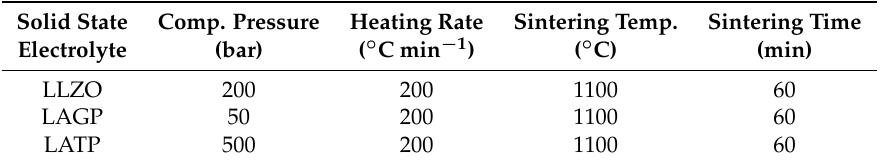
Table 1. Sample preparation pressure and sintering parameters of the three different solid state electrolytes measured for thermal